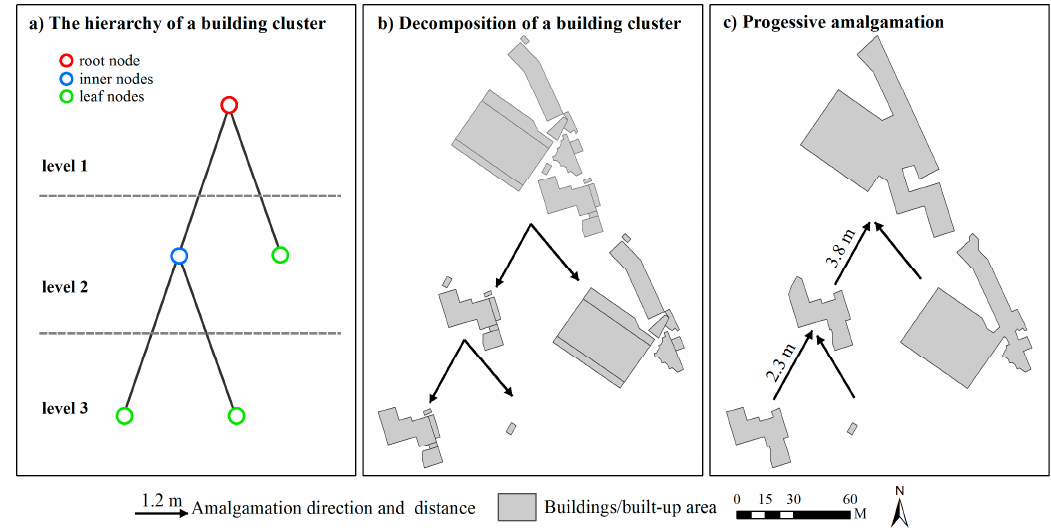
Figure 2. Examples for decomposing a building cluster and progressive amalgamation are shown for ( a ) the hierarchy of a building cluster; ( b ) corresponding building subgroups in the hierarchy; ( c ) generalized results based on (b).